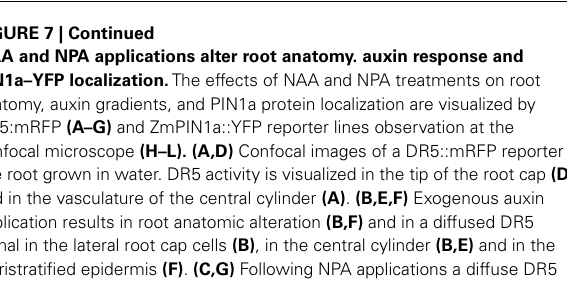
FIGURE 7 | Continued NAA and NPA applications alter root anatomy. auxin response and PIN1a–YFP localization. The effects of NAA and NPA treatments on root anatomy, auxin gradients, and PIN1a protein localization are visualized by DR5:mRFP (A–G) and ZmPIN1a::YFP reporter lines observation at the confocal microscope (H–L). (A,D) Confocal images of a DR5::mRFP reporter line root grown in water. DR5 activity is visualized in the tip of the root cap (D) and in the vasculature of the central cylinder (A) . (B,E,F) Exogenous auxin application results in root anatomic alteration (B,F) and in a diffused DR5 signal in the lateral root cap cells (B) , in the central cylinder (B,E) and in the pluristratified epidermis (F) . (C,G) Following NPA applications a diffuse DR5